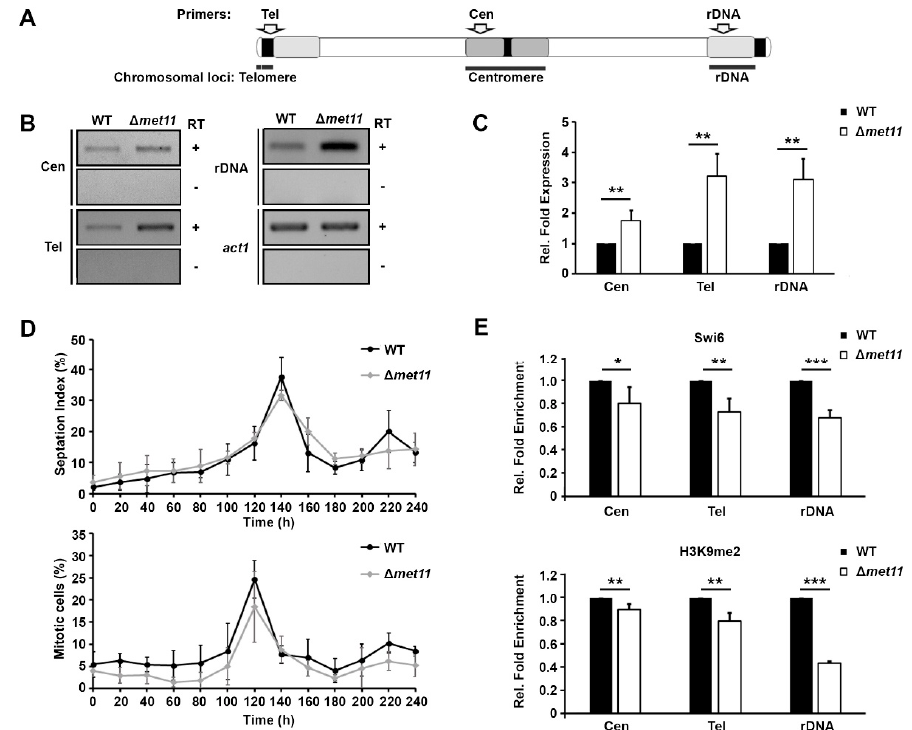
Figure 2. Deletion of met11 disrupts heterochromatic integrity at pericentromeric, sub-telomeric and ribosomal DNA loci. ( A ) Schematic diagram to show the chromosomal location of constitutive heterochromatic loci and the location of the primers used in the study. ( B ) Detection of transcripts derived from centromeric (Cen), sub-telomeric (Tel), and ribosomal DNA (rDNA) heterochromatic loci of asynchronous WT and Δ met11 cells using RT-PCR (RT). +, RT-PCR reaction with active reverse transcriptase; -, RT-PCR reaction with inactivated reverse transcriptase. act1 , actin gene as loading control. Results shown are representative of three independent experiments. ( C ) Quantification of levels of heterochromatic tran- scripts in ∆ met11 relative to WT and normalized to act1 transcription in ( B ). Bars and error bars represent mean ± S.D. respectively obtained from three experiments. **: p < 0.01. ( D ) Percentage of 2 N cells with (septation index) or without septum (mitotic cells) of HU block-release-synchronized Δ met11 and WT cells. n ≥ 200. Bars and error bars represent mean ± S.D., respectively from three experiments. ( E ) Chromatin immunoprecipitation analyses of Swi6 and H3K9me2 levels associated with heterochromatic sequences at centromeric (Cen), sub-telomeric (Tel) and ribosomal DNA (rDNA) regions in Δ met11 relative to WT and normalized to act1 signals using quantitative (q)-PCR. Bars and error bars represent mean ± S.D. respectively obtained from three independent experiments. *: p < 0.05, **: p < 0.01, ***: p < 0.001.